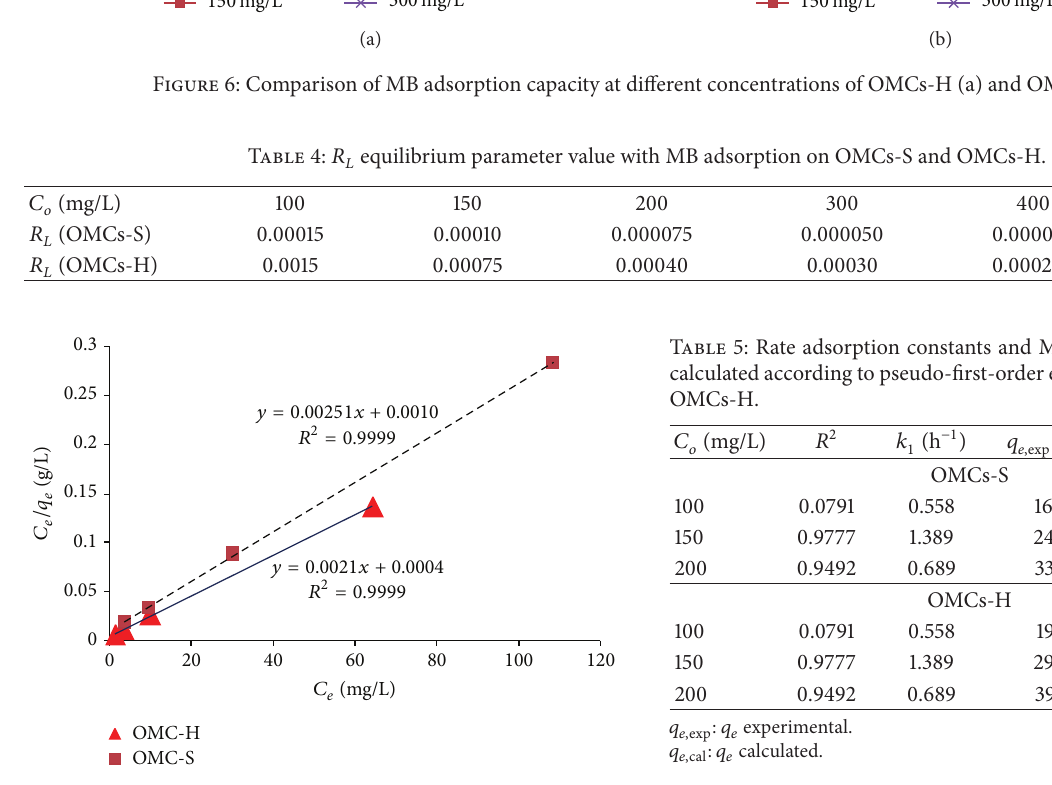
Figure 7: Langmuir plot for the adsorption of MB onto the OMCs- H and OMCs-S.